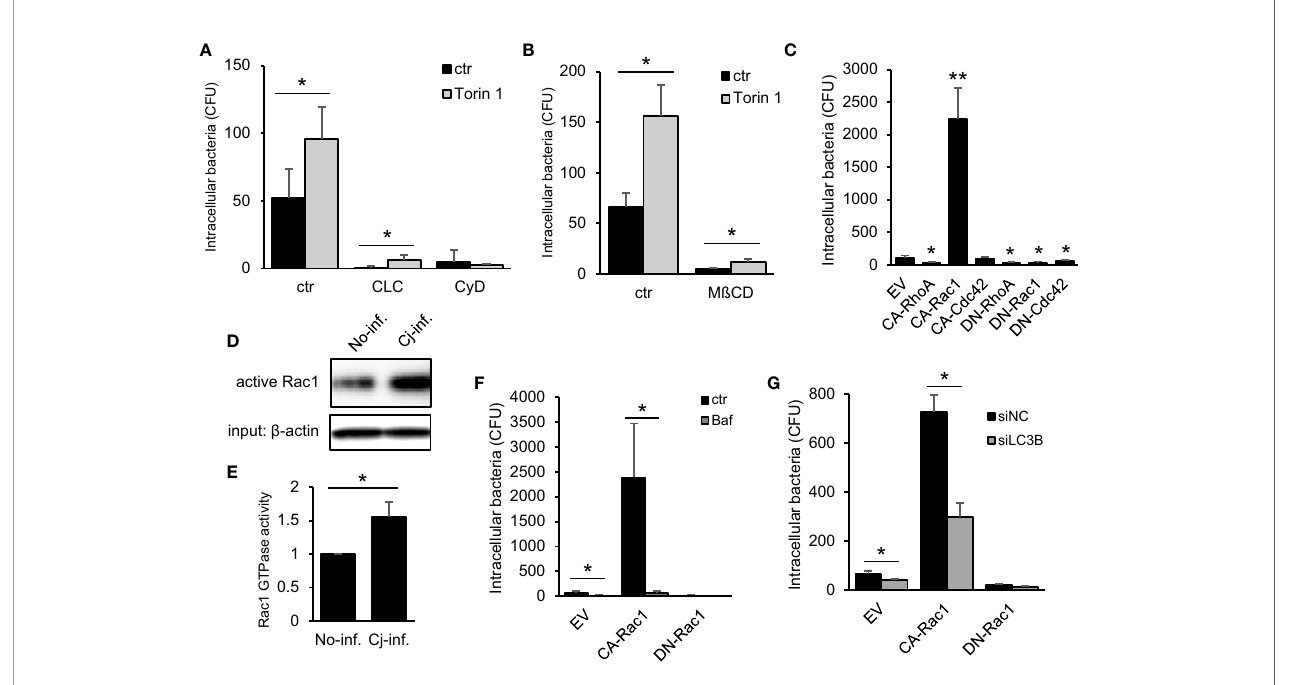
FIGURE 3 | Association between Autophagy- and Rac1-mediated C. jejuni invasion pathway. (A) HeLa cells were treated with 10 m M Cholchicine (CLC), 300 nM Cytochalasin D (CyD) with or without 1 m M Torin 1 for 3 h. The number of invaded C. jejuni was estimated by gentamicin protection assay at 1 h p. i. (B) HeLa cells were treated with 1 m M Torin 1 for 3 h, and 3 mM Methyl-beta-cyclodextrin (M b CD) was additionally treated for last 1 h. Intracellular bacterial number was measured by gentamicin protection assay at 1 h p. i. (C) Empty vector (EV) and, constitutive active form (CA) and dominant negative form (DN) of RhoA, Rac1, and Cdc42 were transfected in HeLa cells. The number of intracellular C. jejuni was estimated by gentamicin protection assay at 1 h p. i. (D) Intracellular active Rac1 level at 6 h p. i. was measured by Western blotting. (E) Band intensity of active Rac1 was quanti fi ed. (F) CA-Rac1 or DN-Rac1 expressed HeLa cells were treated with 200 nM Ba fi lomycin A1 (Baf) for 3 h. The number of intracellular C. jejuni was estimated by gentamicin protection assay at 1 h p. i. (G) HeLa cells were co-transfected EV, CA-Rac1, or DN-Rac1 and siNC or siLC3B. The number of intracellular C. jejuni was estimated by gentamicin protection assay at 1 h p. i. All data are expressed as means ± standard deviations from 3 independent experiments. Differences were evaluated with Two-tailed Student ’ s t-test. * p < 0.05, ** p <